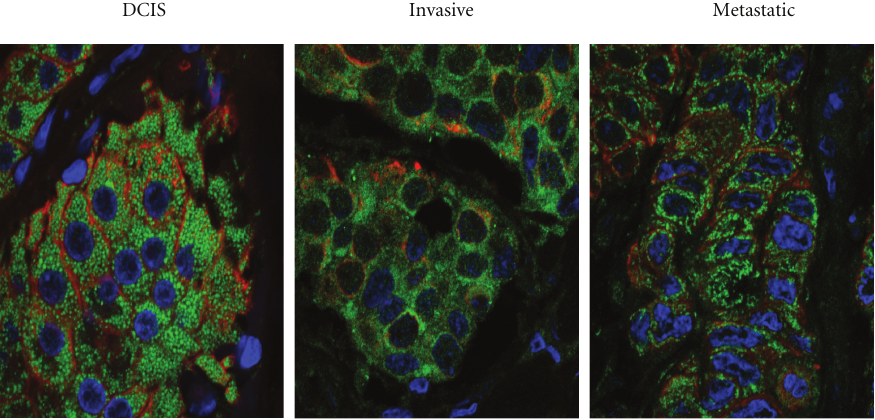
Figure 5: PAD2 (green) is expressed in luminal epithelial cells of preinvasive, invasive, and metastatic human mammary tumors. Cytokeratin (red) staining di ff erentiates luminal epithelial type from myoepithelial cells. (Magnification